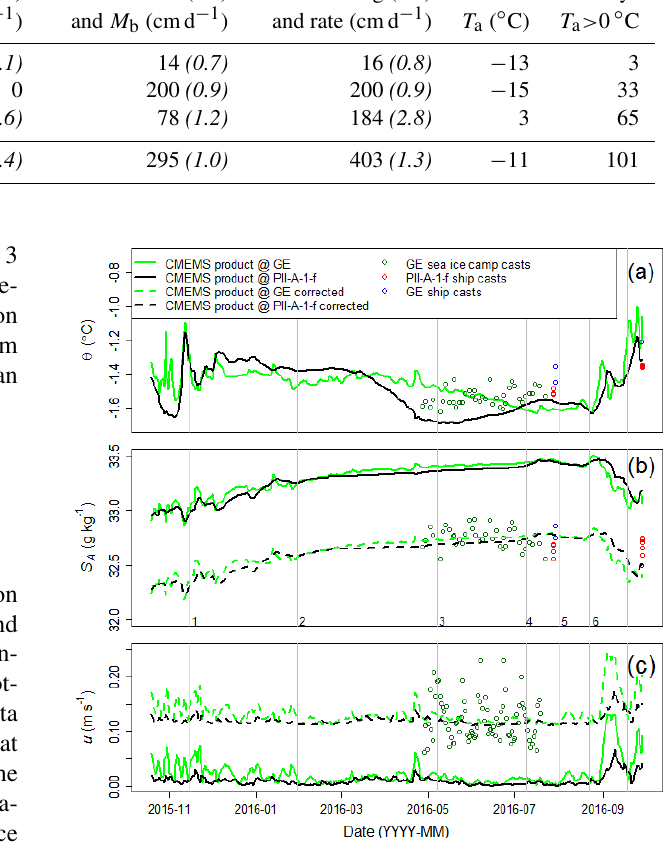
Table 1. Ablation and total thinning magnitudes and rates per ablation period. Air temperature ( T a ) data for each period are also included. Inconsistencies exist between the summed ablation and thinning magnitudes or between the ratios of surface: basal ablation magnitudes versus rates are due to rounding. M s and M b (in italic font) represent daily surface and basal ablation rates, respectively. Ablation Dates Surface ablation (cm) Basal ablation (cm) Total thinning (cm) Mean period